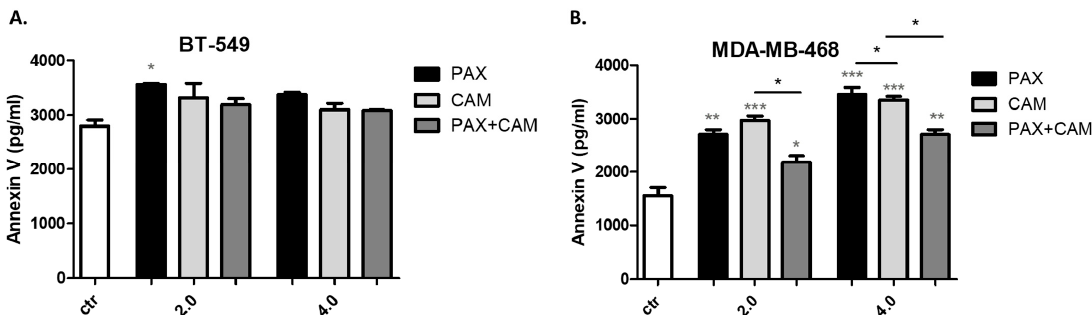
Figure 8. Interpolated protein concentration of Annexin V (pg/mL) in 100 μ g/mL of protein, extracted from ( A ) BT-549 and ( B ) MDA-MB-468 TNBC cells after CAM and PAX treatment, used individually or in combination. BC cells were exposed to drugs treatment for 48h using selected ratios of the IC 50 determined in the MTT assay (2.0 = IC 50 , 4.0 = 2IC 50 ). Concentrations of Annexin V were measured in triplicate and interpolated from the Annexin V standard curve and corrected for sample dilution. The interpolated dilution factor corrected values are plotted (mean ± SD, n = 3).; one-way ANOVA, Tukey’s post-hoc testing; * p < 0.05, ** p < 0.01, *** p < 0.001. Grey *-data vs. ctr; black *-single treatment vs. combined